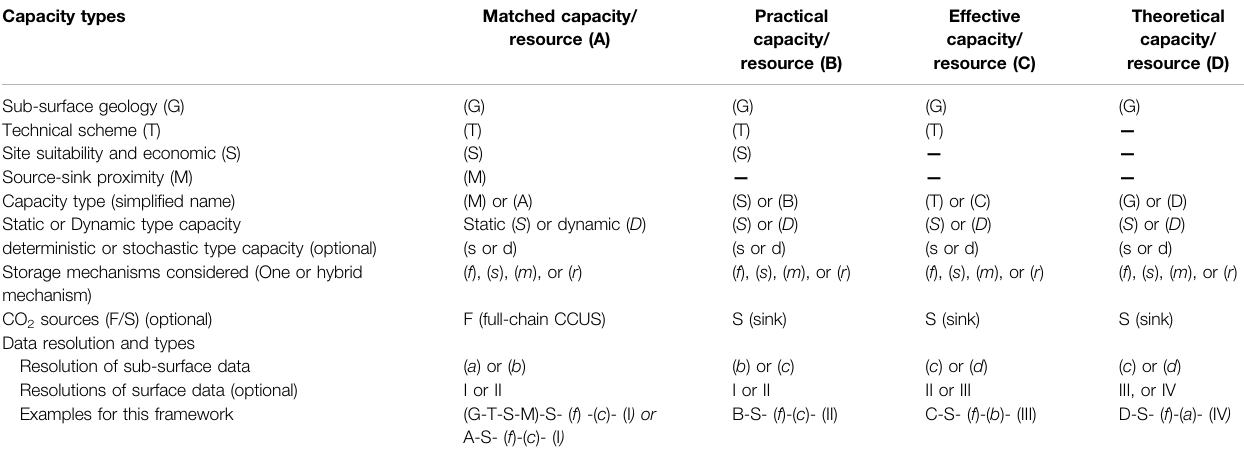
TABLE 4 | Proposed hierarchical capacity with descriptions of data types and